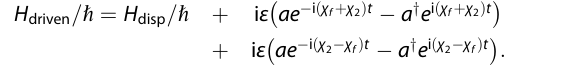
Josephson Parametric Ampli fi er (JPA), with design as in 26 .